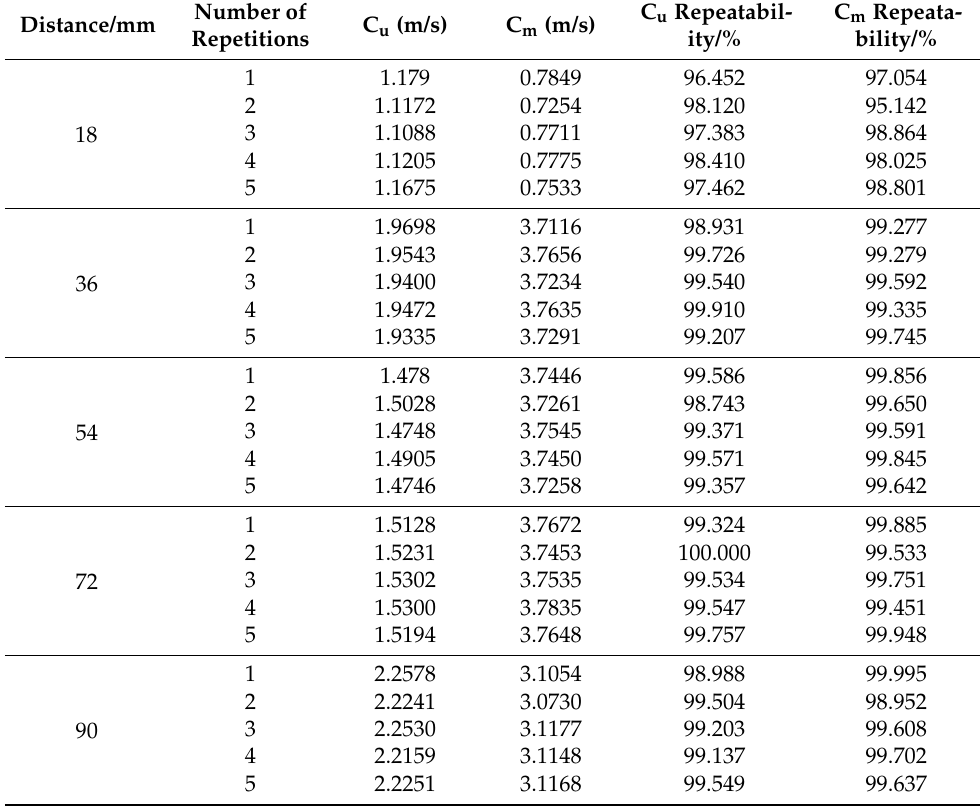
Table 3. LDV test repeatability